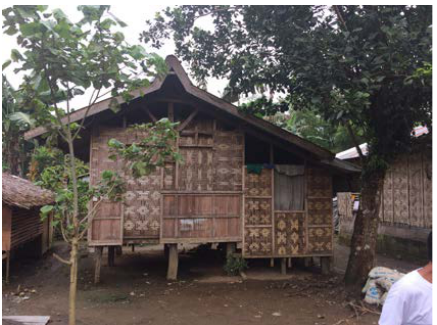
Figure 4. Example house from Calabnian showing woven palm façade, roof level ventilation, raised ground floor, and sunken post foundations.